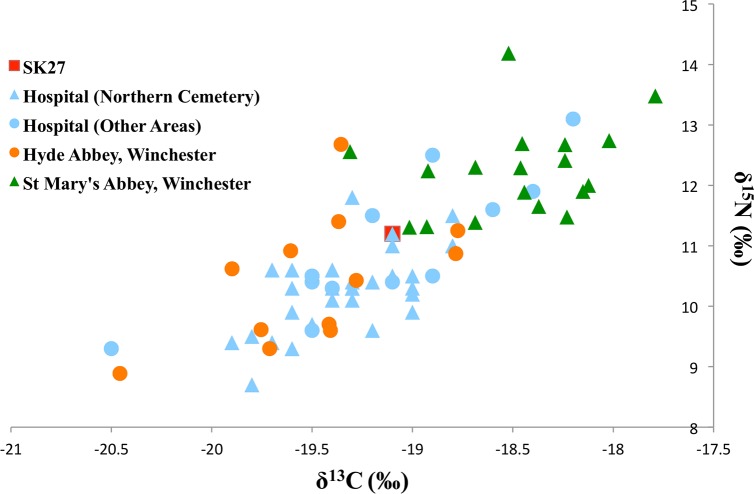
Rib collagen δ13C and δ15N results from Sk27 and nearby medieval populations.